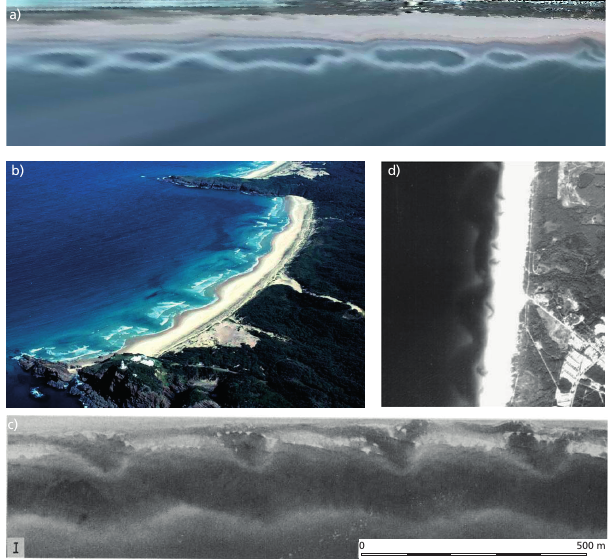
Figure 5. Examples of coupled morphology, showing (a) out-of- phase (180 ◦ ) coupled sandbars, (b) out-of-phase coupling between sandbar and shoreline (courtesy of A.D. Short), (c) in-phase (0 ◦ ) coupled sandbars (taken from Bowman and Goldsmith, 1983), and (d) two inner-bar rip channels for each outer-bar bay (taken from Castelle et al.,